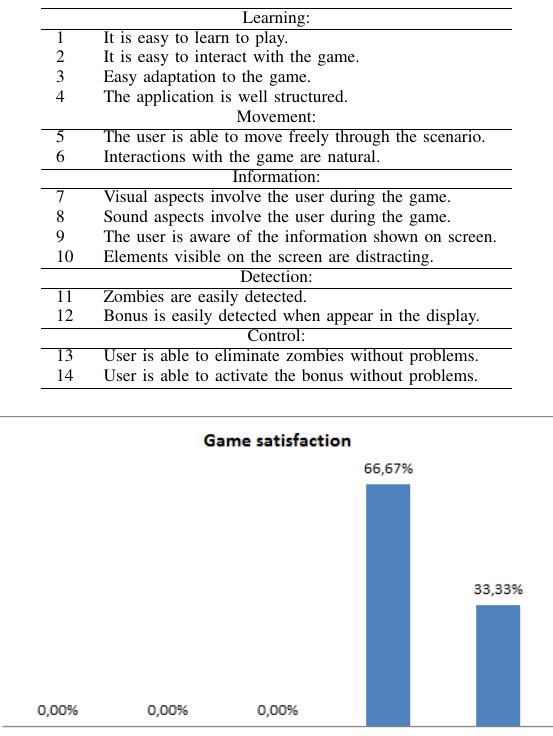
TABLE V: MAIN STATEMENTS INCLUDED IN THE QUES- TIONNAIRE. Learning: 1